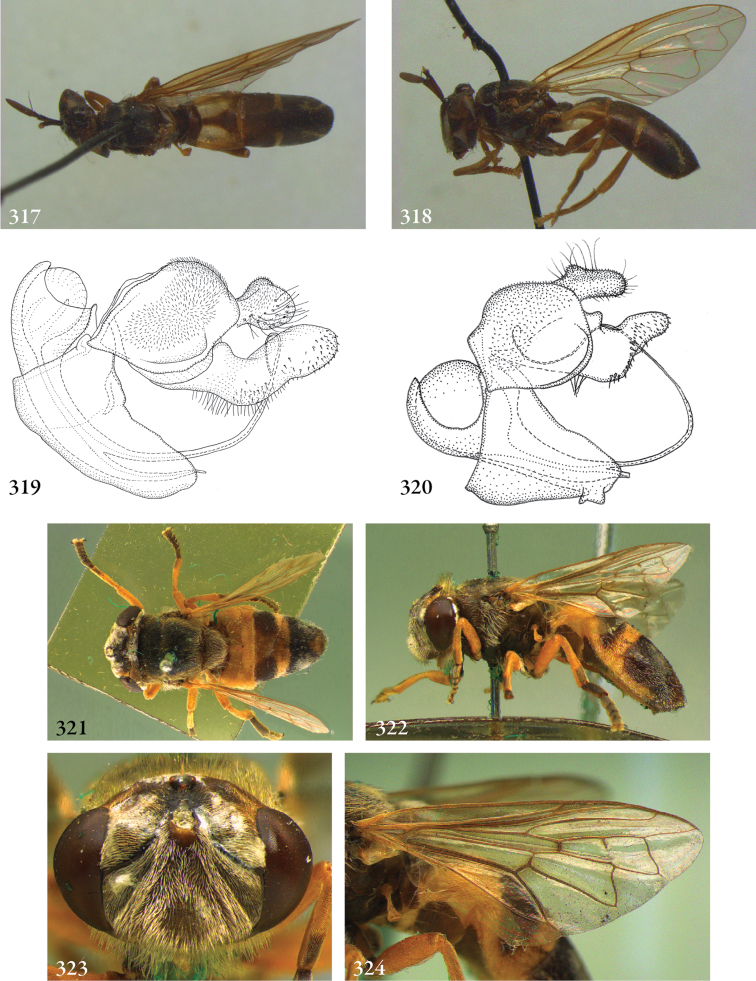
317–319
Pseudomicrodon biluminiferus male (holotype): 317 habitus dorsal 318 habitus lateral 319 genitalia lateral 320
Pseudomicrodon smiti male (holotype), genitalia lateral 321–324
Ptilobactrum neavei male (holotype): 321 habitus dorsal 322 habitus lateral 323 head frontal 324 wing.